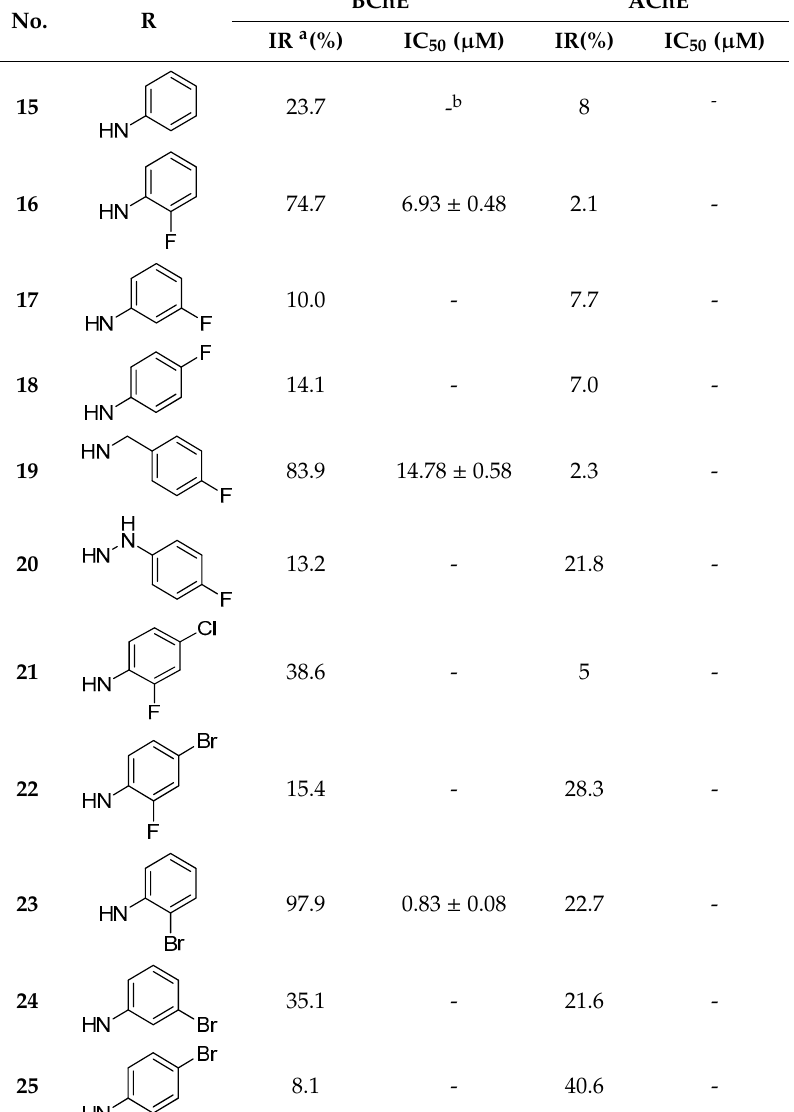
Table 3. The inhibitory activities of compounds 15 – 30 against ChEs.